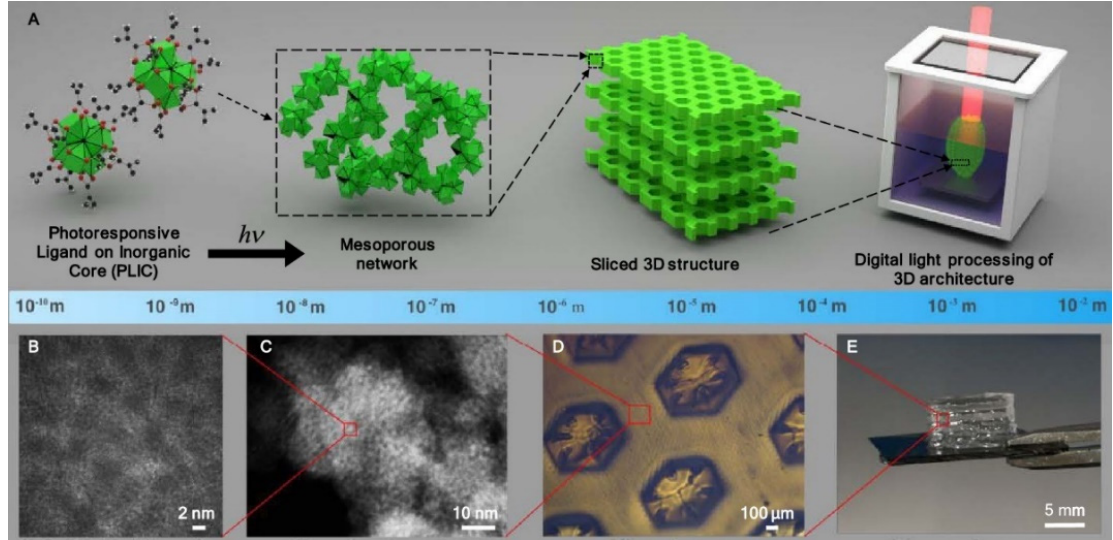
Figure 6. ( A ) Schematic representation of the printing process using photoresponsive ligand on the inorganic core (PLIC) as the building units and structured by a series of 2D UV images in the 3D printer. ( B ) Image showing zirconium oxide cluster with MAA surface ligands. ( C ) Pores were seen after the building blocks were connected. ( D ) Printed structure showing shape control for each layer. ( E ) Layer–by–layer stacking was seen in the structure in millimeter-scale (reproduced with permission from [55], copyright 2019 American Chemical Society).